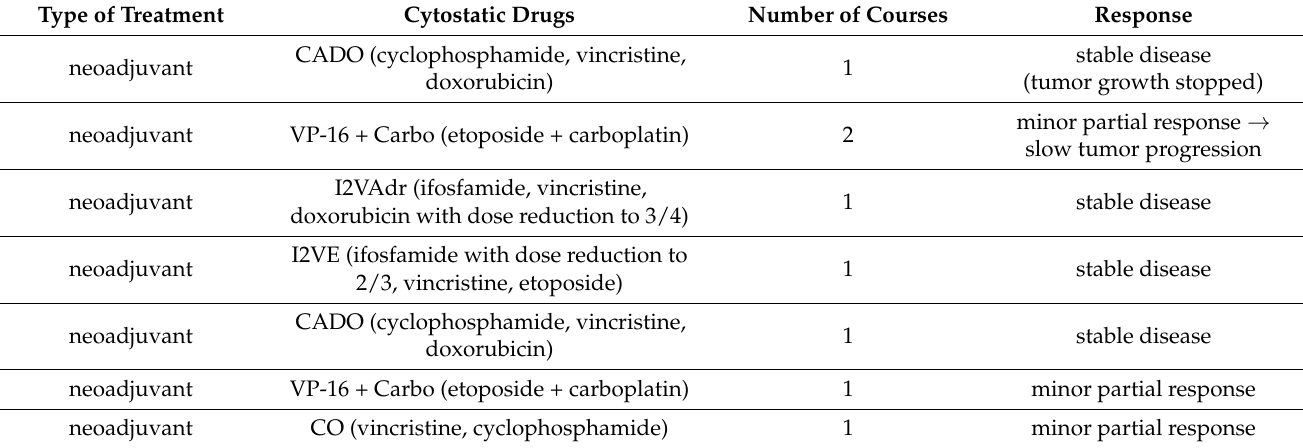
Table 1. Chemotherapy in patient 1.